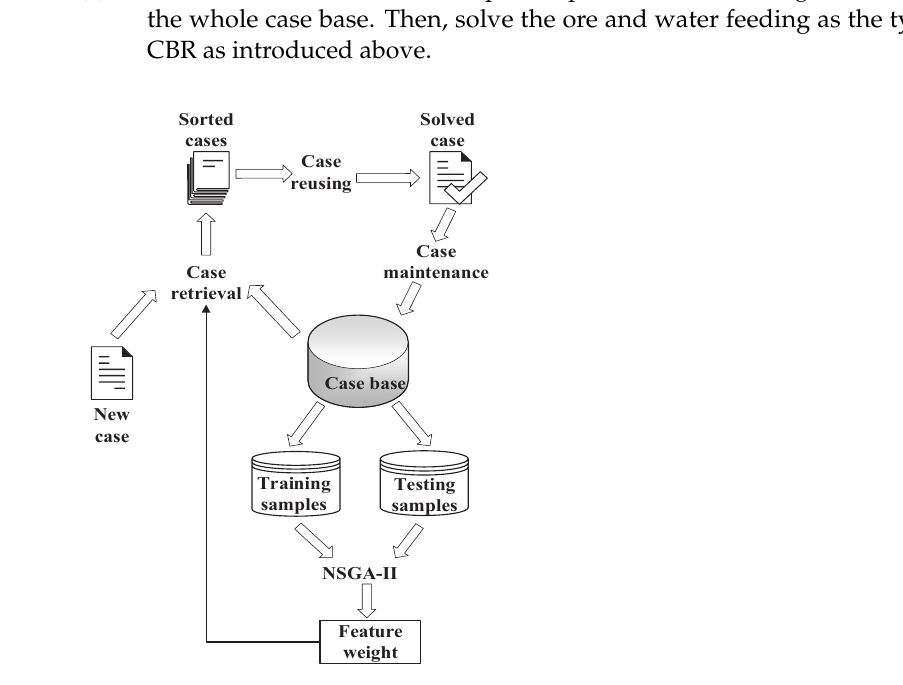
Figure 4. Strategy diagram of the proposed optimization combining CBR with